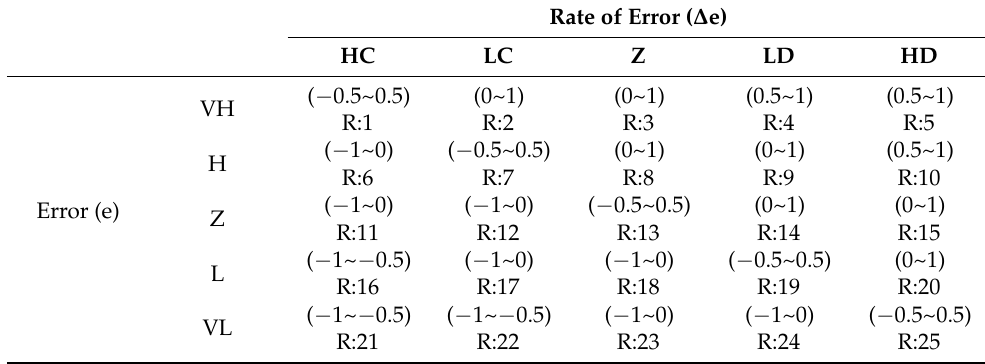
Table 9. Fuzzy rules (R) for supercapacitor.